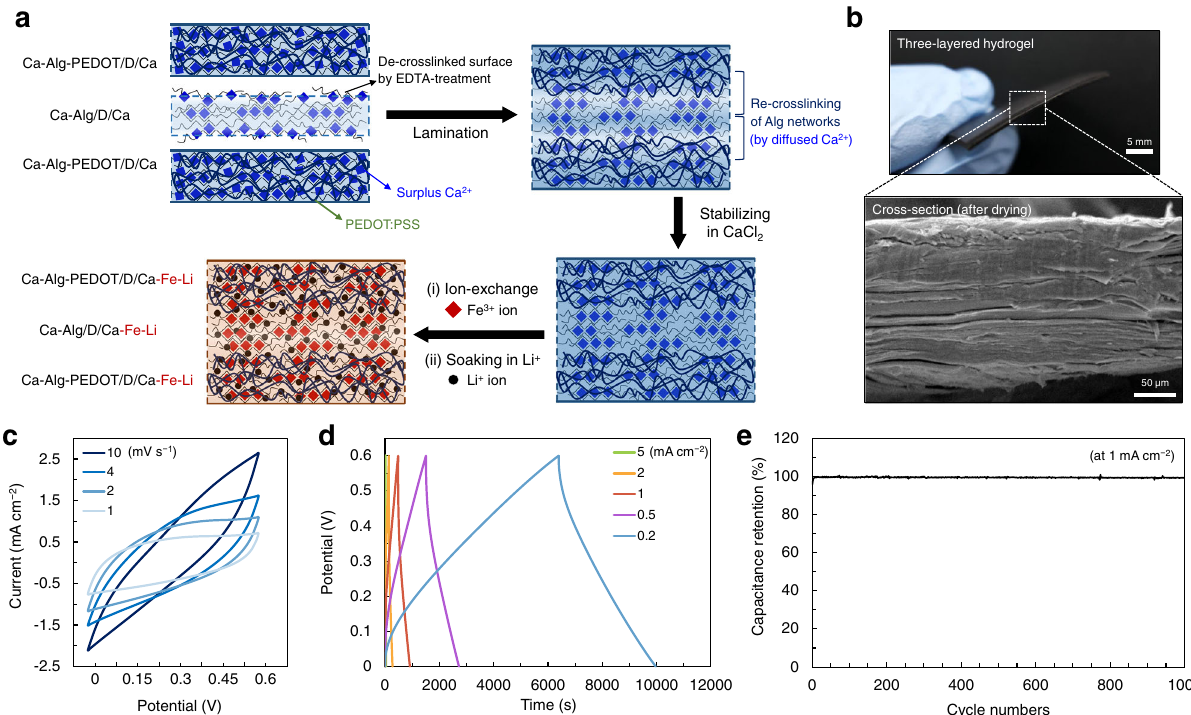
Fig. 5 Aqueous supercapacitor composed of AC electrodes and three-layered hydrogel electrolyte. a Schematic of fabricating three-layered hydrogel electrolyte. b Photograph and cross-sectional SEM image of the three-layered hydrogel. c Cyclic voltammetry (CV) curves at different scan rates. d Galvanostatic charge-discharge (GCD) curves at different current densities. e Capacitance retention during 1000 charge-discharge cycles at a current density of 1 mA cm − 2 , showing stable cycle